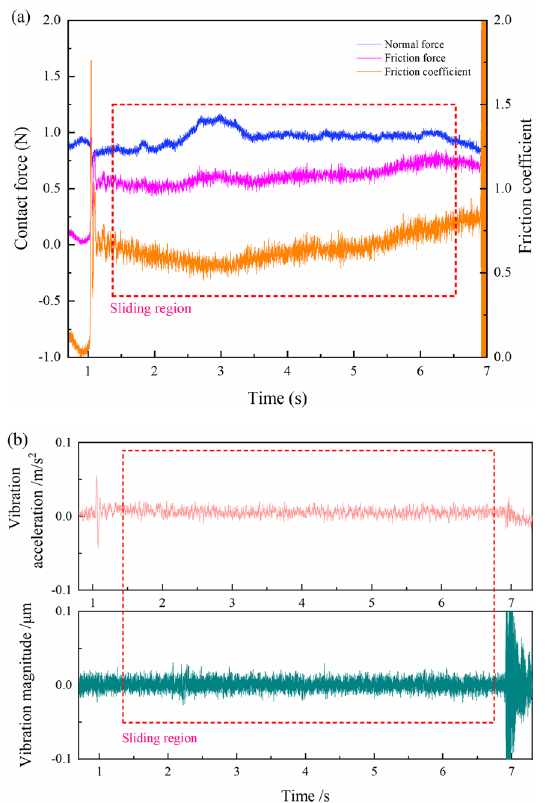
Figure 9 Analysis parameters for passive sliding against PTFE#3, including contact force, friction coefficient, vibration acceleration and vibration magnitude